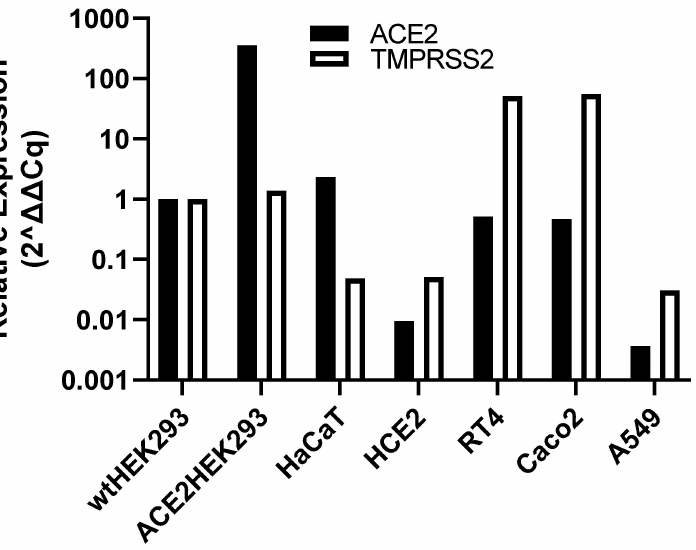
Figure 1. ACE2 and TMPRSS2 mRNA expression in human epithelial cell lines. Total RNA was isolated from the cell lines, converted to cDNA and ACE2 and TMPRSS2 mRNA levels determined by RT-qPCR. The data are shown relative to expression in wild-type (wt) HEK293 cells (=1) and are the means from at least 2 independent